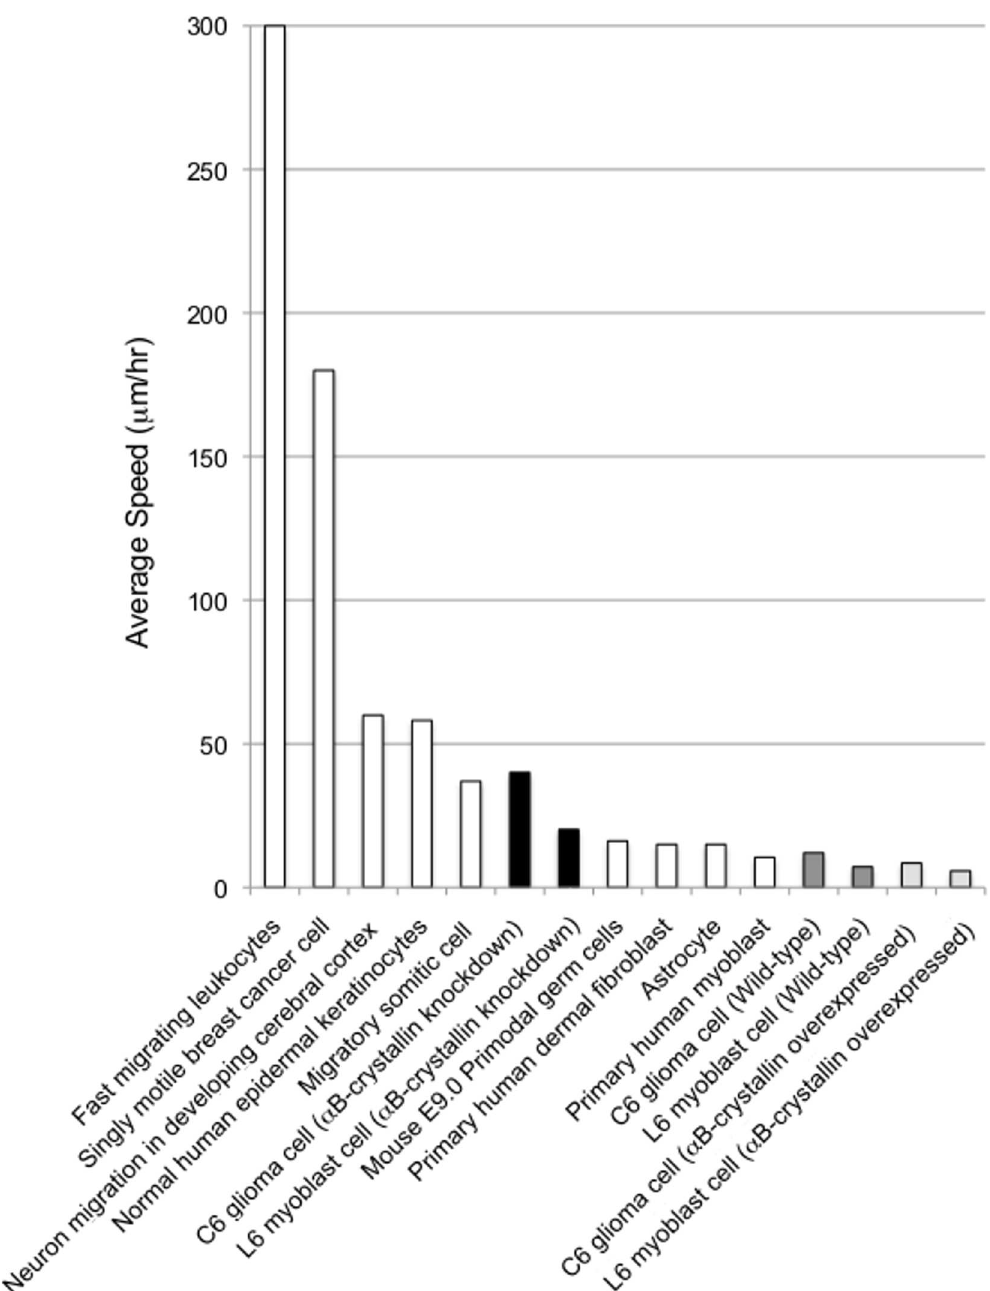
Fig 13. Averagemigration speed of cells. Fast migratingleukocytes(~300–1500 μ m/hr.) [37]; singlemotile breast cancer cells (180 μ m/hr) [38]; neuronmigration in developing cerebralcortex (~60 μ m/hr) [39]; normal human epidermal keratinocytes (58.2 ± 2.4 μ m/hr) [40]; migratory somatic cells (37 ± 15 μ m/hr) [41]; α B-crystallin knockdownC6 gliomacells (40.1 μ m/hr, this study); α B-crystallin knockdown L6 myoblast cells (20.2 μ m/hr, this study); mouse E9.0 primordialgerm cells (16.2 ± 2.5 μ m/hr) [42]; primary human dermalfibroblasts(15 μ m/hr) [43]; astrocytes (15 μ m/hr) [44]; primary humanmyoblasts (10.5 ± 5.8 μ m/hr) [45]; C6 gliomacell (12.1 μ m/hr, this study); L6 myoblast cells (7.2 μ m/hr, this study); α B-crystallin-overexpressing C6 gliomacells (8.5 μ m/hr, this study); α B- crystallin-overexpressing L6 myoblast cells (5.8 μ m/hr, this study).